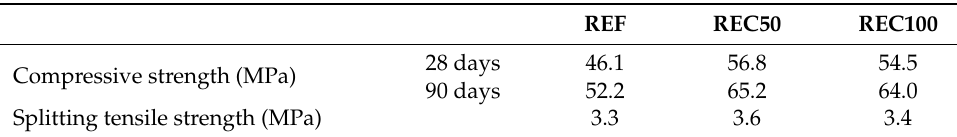
Figure 9. The splitting tensile strength test: a samplebefore (left) and after (right) the testing procedure. Table 4. Mechanical properties.